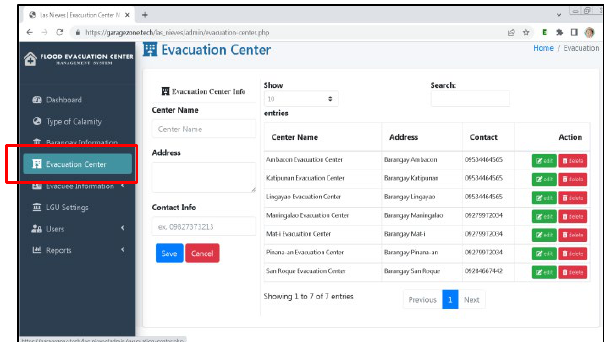
Figure 18. The Evacuation Center Interface